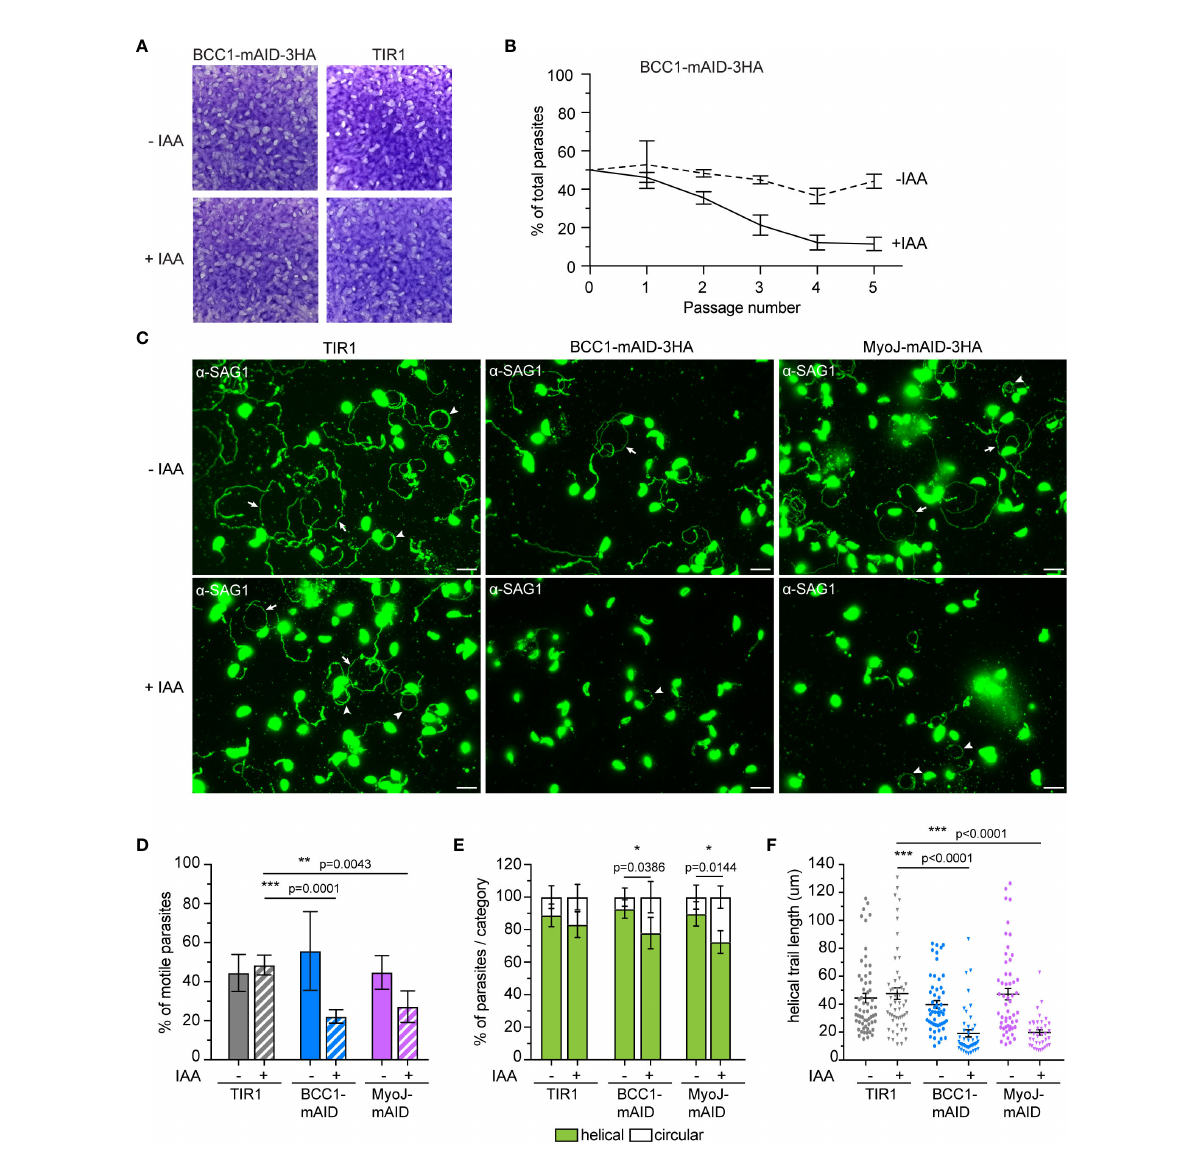
FIGURE 7 BCC1 depletion impairs parasite fi tness and motility in vitro. (A) Plaque assays performed with BCC1-mAID-3HA/MyoJ-2Ty and the parental TIR1 strains over 7 days treated or not with auxin (IAA). (B) Competition assay performed over 5 passages (14 days) with